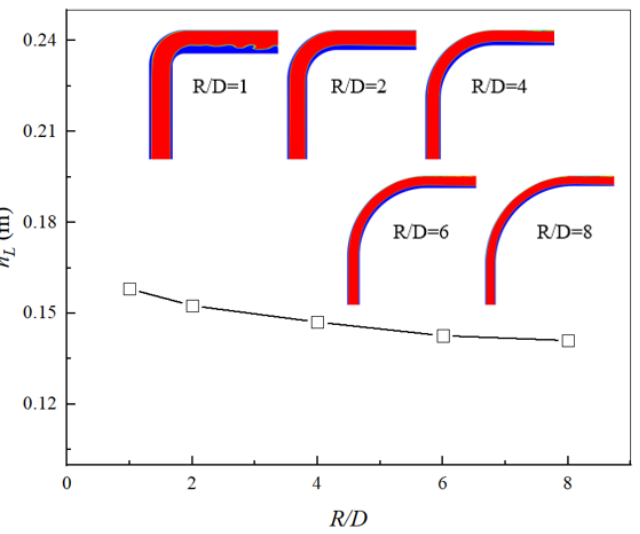
Figure 11. The head loss and the oil–water core–annular flow in the elbows with different R/D (90° elbow; the oil and water velocity is 1 m/s).